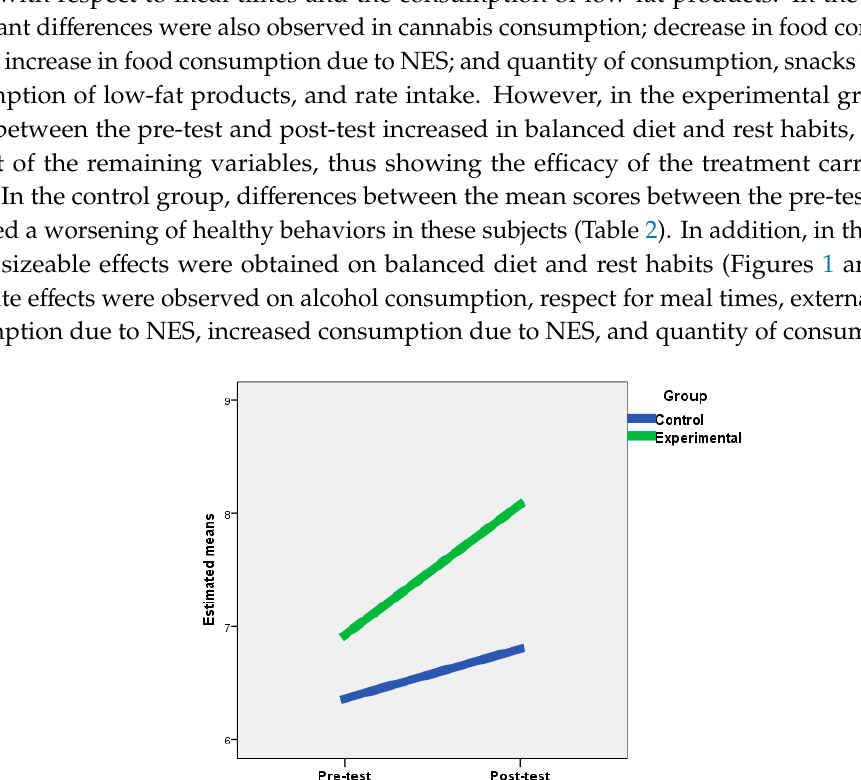
Figure 1. Changes in rest habits for the experimental and control groups after the intervention.